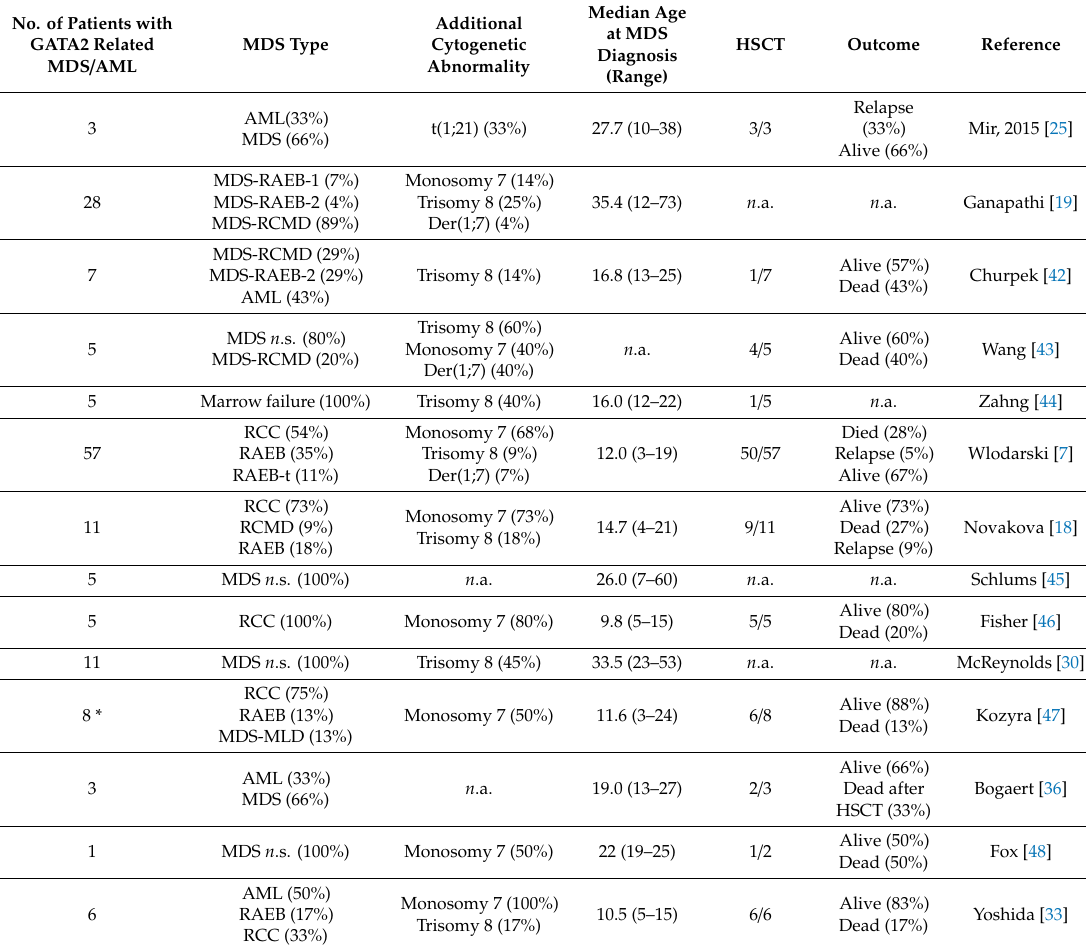
Table 2. Cases described of GATA2 related MDS / AML. * patients with GATA2 synonymous mutations. No. of Patients with GATA2